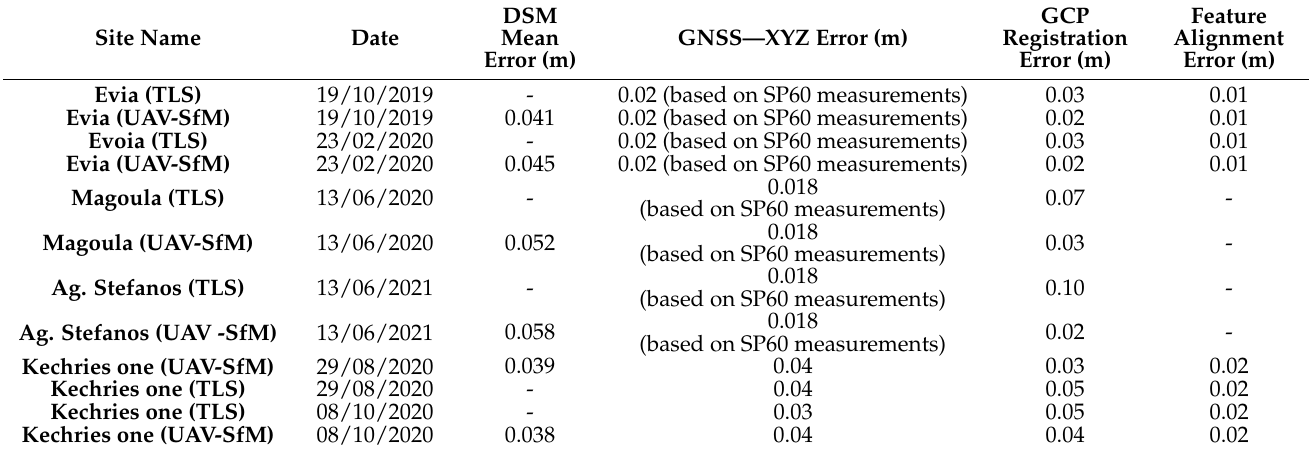
Table 6. GNSS–XYZ error, GCP registration error and feature alignment error, calculated for each location and scan, using either the UAV-mounted camera or the t-LiDAR. See text for details in error